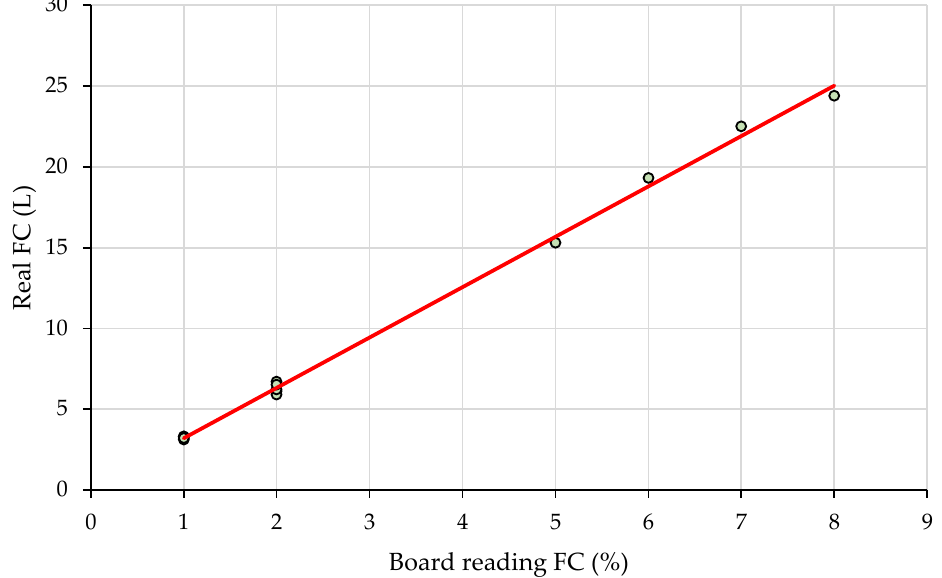
Figure 3. Dependence relationship between the real and onboard readings of fuel consumption.